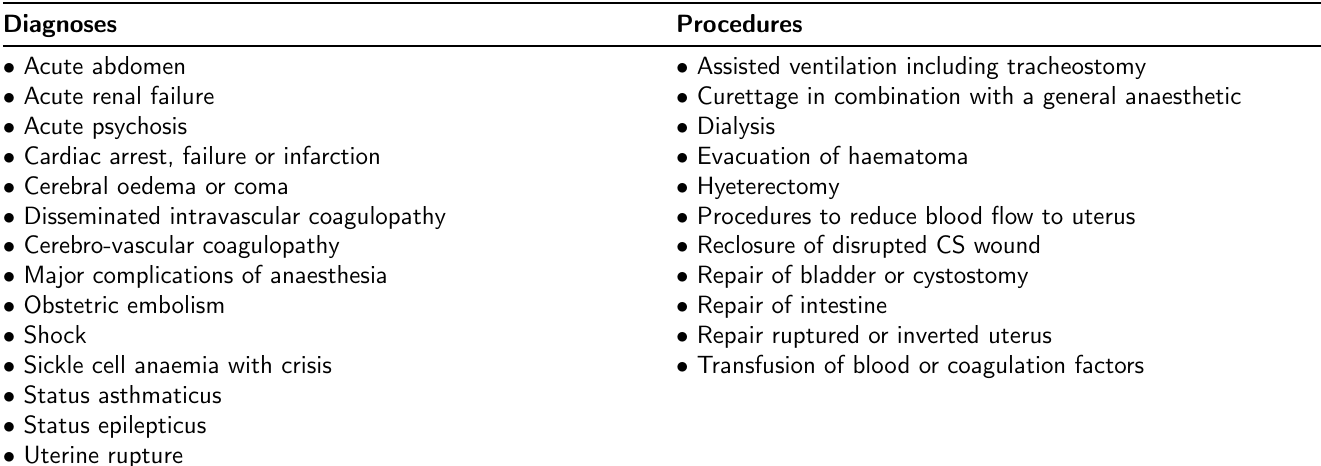
Supplementary table 1: Diagnoses and procedures included in severe maternal morbidity indicator [32] Diagnoses